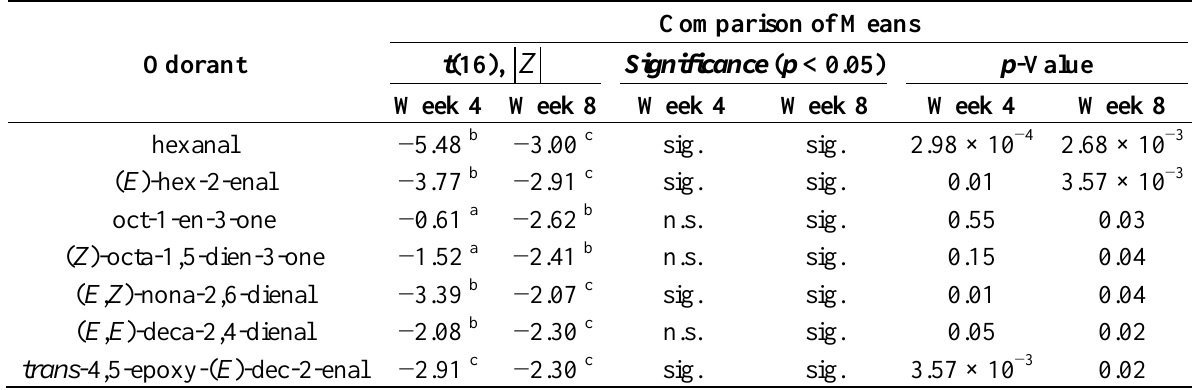
Table 7. Statistical data on comparison of means between formulations with and without antioxidants (week 4, week 8). t and Z as critical values of the respective statistical test.